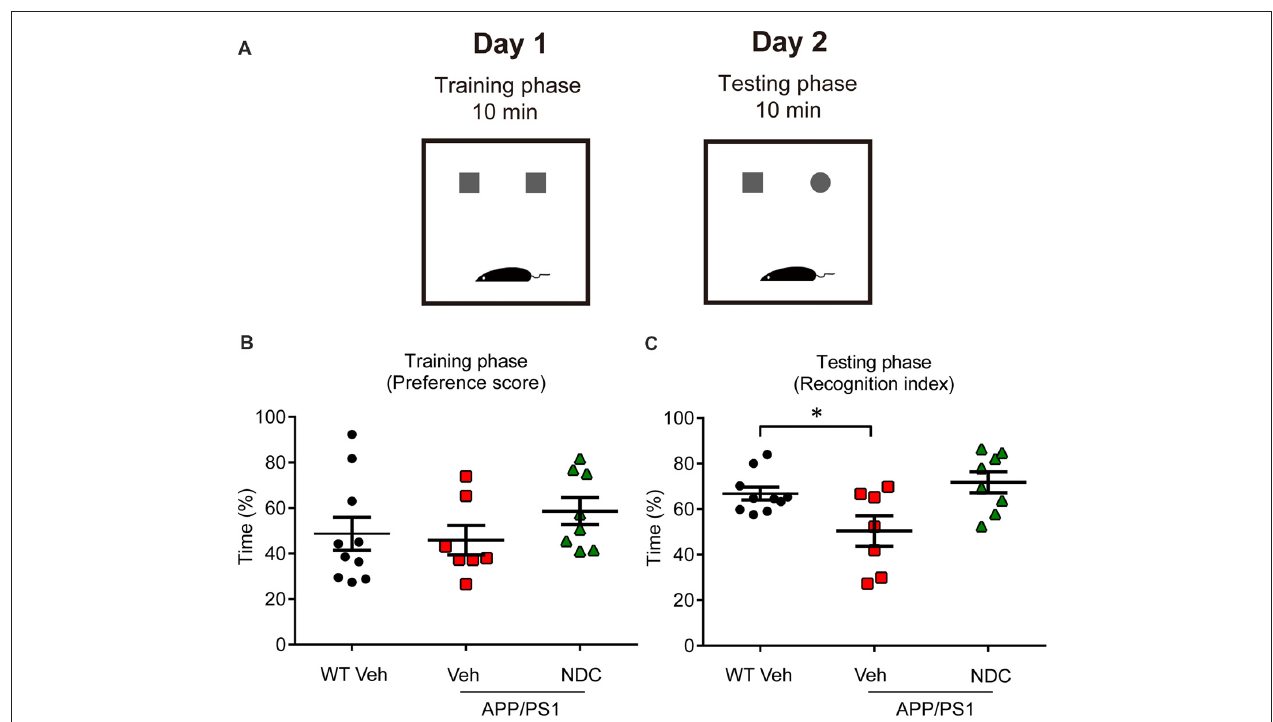
FIGURE 2 | NDC improves memory retention in APP/PS1 mice. (A) Diagram of Novel object recognition (NOR) analysis. (B,C) Preference scores of training phase (B) and Recognition Index of testing phase (C) during a 10-min testing phase are shown, respectively. Data are presented as mean ± SEM, WT group n = 10, Veh group n = 7, NDC group n = 8. ∗ p < 0.05, analyzed by one-way ANOVA followed by Bonferroni